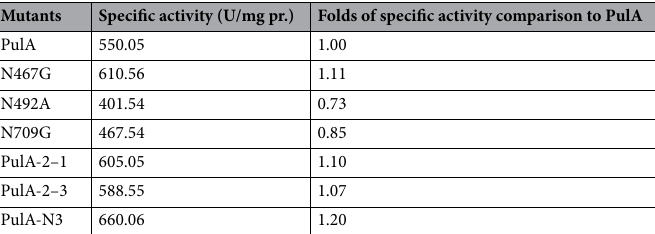
Mutants Specific activity (U/mg pr.) Folds of specific activity comparison to